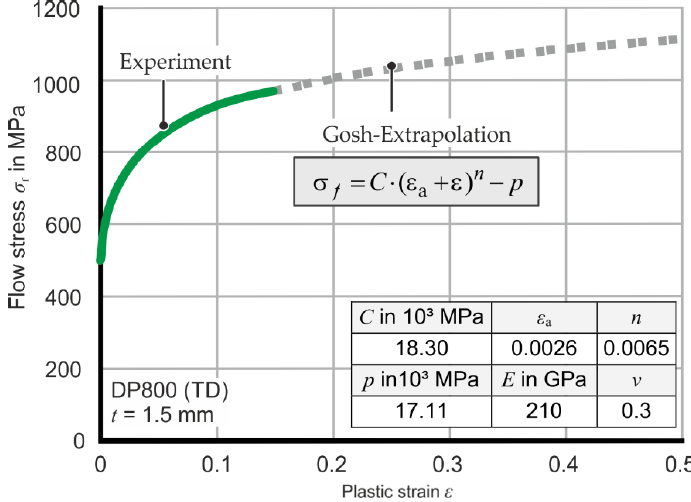
Figure 2. Flow curve of the investigated DP800 steel with experimental data and extrapolation according to Gosh.